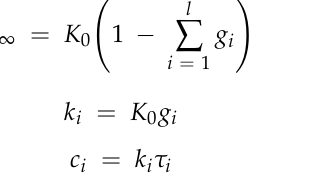
Figure 2. Meshing analysis of spur gear. As